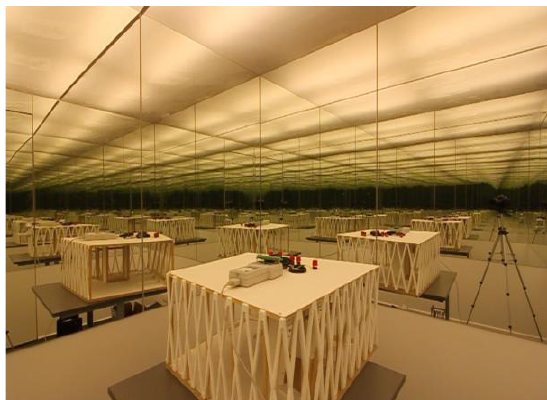
Fig. 2. Overcast sky simulator interior view